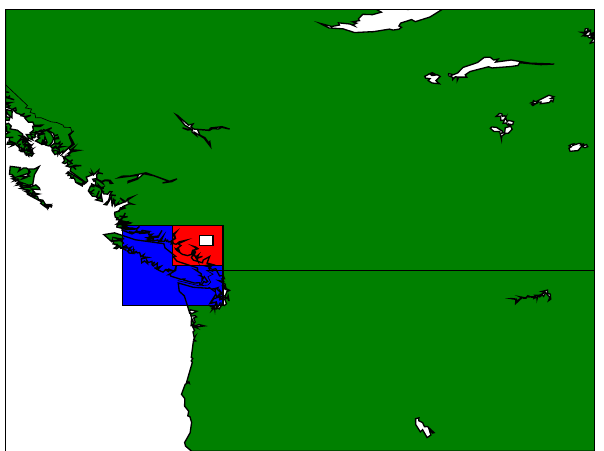
Fig. 1. A map showing the grid box that contains Whistler, BC, Canada for the 4 ◦ × 5 ◦ (blue), 2 ◦ × 2.5 ◦ (red) and 0.5 ◦ × 0.667 ◦ (white)